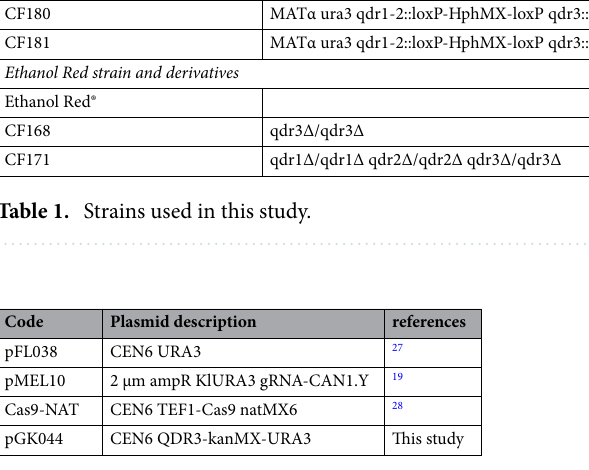
Table 2. Plasmids used in this